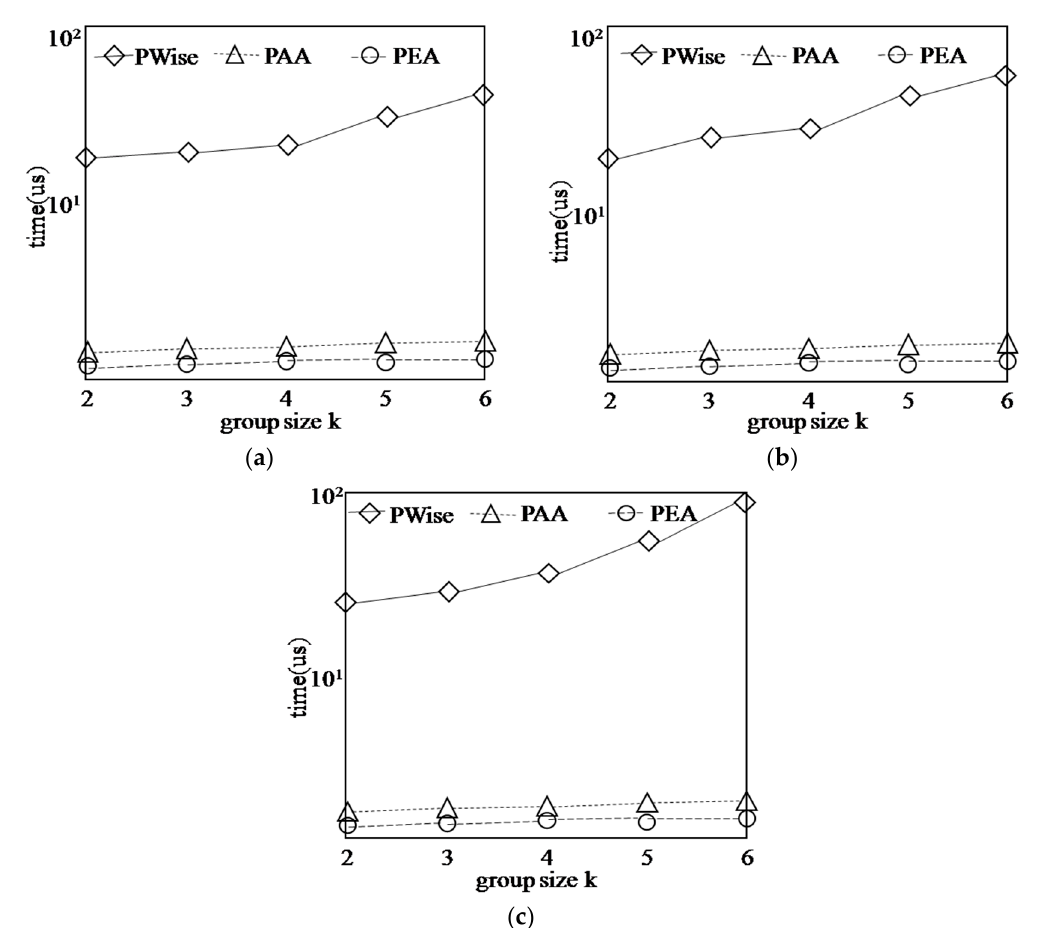
Figure 13. Updating skyline layers. ( a ) COR; ( b ) IND; (c) ANTI-COR.